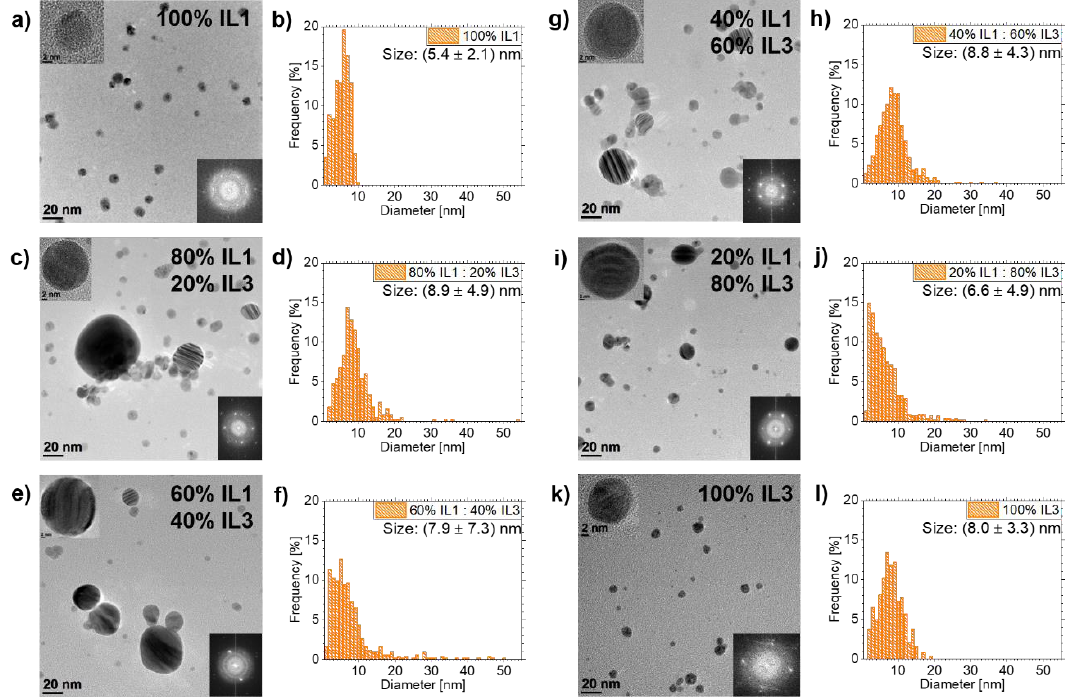
Figure 4. Overview of TEM results of Ag NPs sputtered in IL1/IL3 -mixtures and pure ILs as references. TEM images and the corresponding NP size distribution are depicted in ( a ) and ( b ) for pure IL1 . Overview images and NP size distributions for the IL1/IL3 -mixtures are shown in ( c ) and ( d ) for 80 vol.% IL1/ 20 vol.% IL3 , in ( e ) and ( f ) for 60 vol.% IL1/ 40 vol.% IL3 , in ( g ) and ( h ) for 40 vol.% IL1/ 60 vol.% IL3 and in ( i ) and ( j ) for 20 vol.% IL1/ 80 vol.% IL3 . Results of pure IL3 are illustrated in